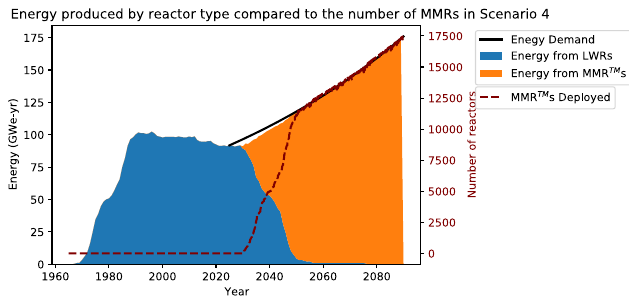
Fig. 11. Energy supplied by each type of reactor compared to the number of MMRs deployed in Scenario